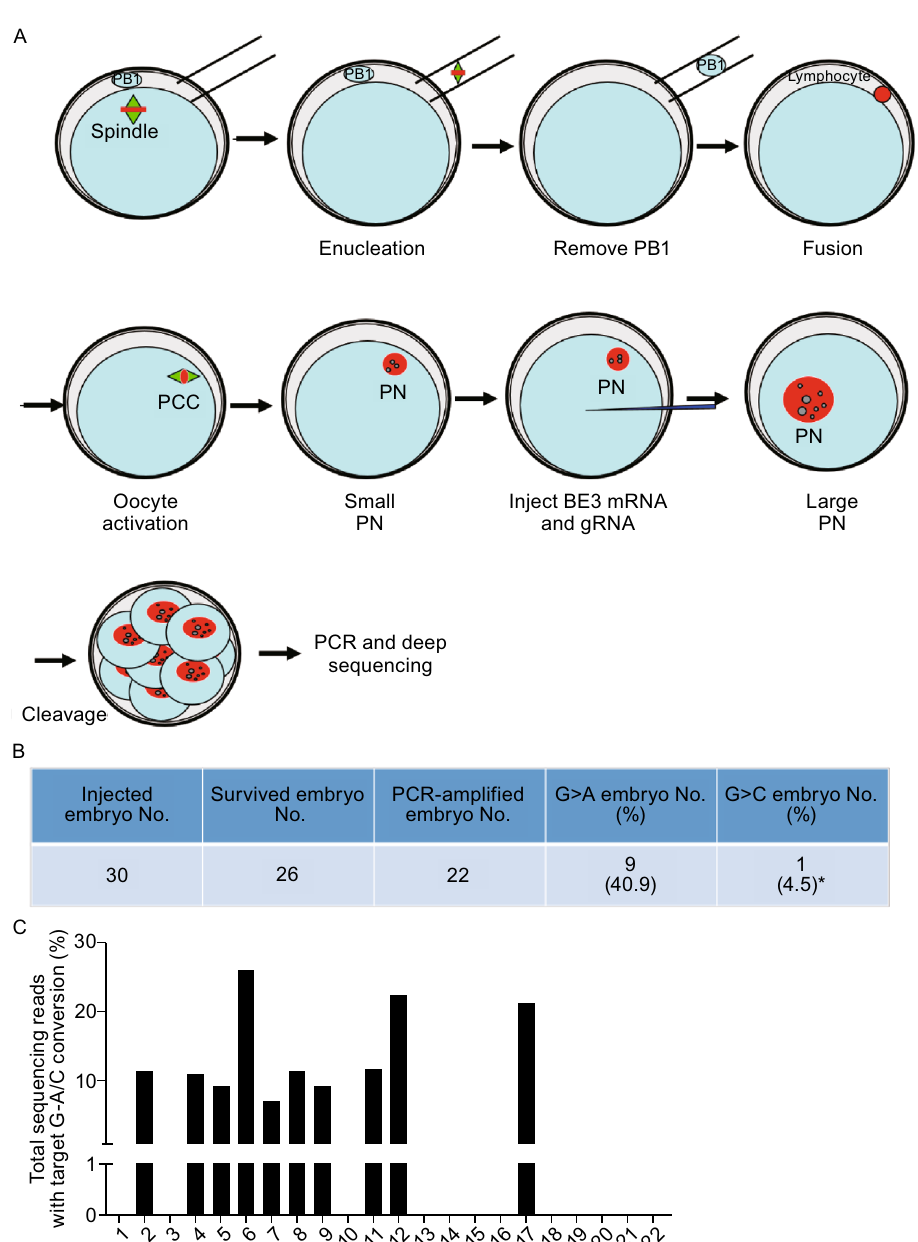
Figure 3. Effective HBB gene correction in human embryos by BE3. (A) Schematic of repairing HBB − 28 (A>G) in cloned human embryos by BE3 and gRNA-1. Cloned HBB − 28 (A>G) mutant homozygous human embryos were generated by fusing lymphocyte cell, fromperipheralbloodofthepatient,with invitro maturedoocytes.AndtheBE3mRNAandgRNAmixturewasinjectedaftertheappearance of pronucleus. HBB site from each embryo was ampli fi ed by PCR and deep sequenced. PB1, the 1st polar body. PN, pronucleus. ZP, zonapellucida. (B) Summary of base editing-mediated point mutation repairing by BE3 in cloned human embryos. The repaired embryo containsG>Aconversionatthe HBB − 28site.*,ThetargetGatthe HBB − 28sitewasconvertedtoCinsteadofA.(C) Deepsequencingto detect successful repairing by BE3 in human embryos. Target site PCR amplicons from these embryos were deep